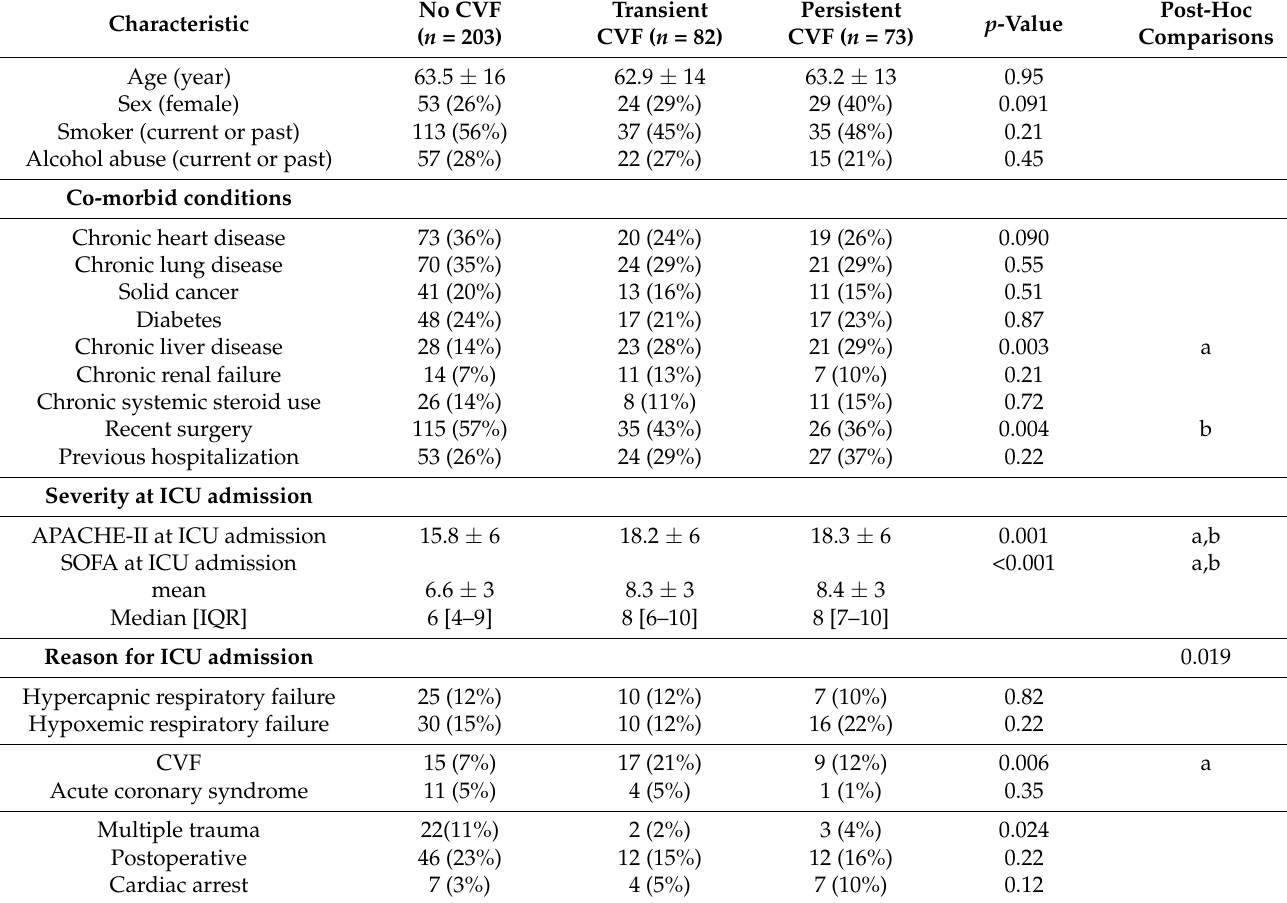
Table 1. Baseline characteristics and